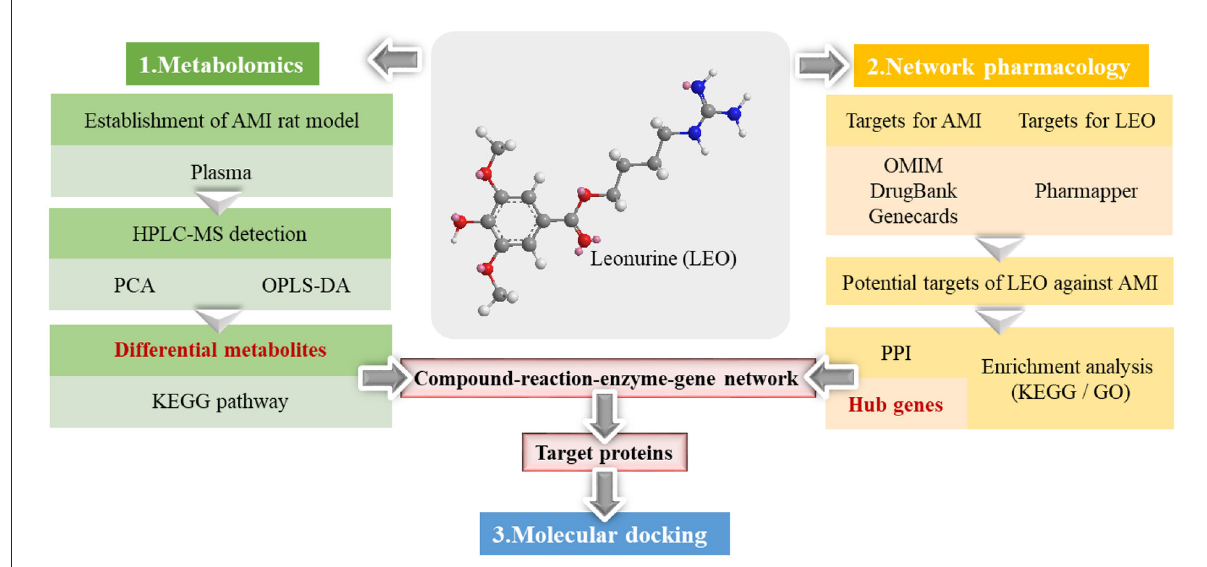
FIGURE1 The workflow of the metabolomics and network pharmacological integration strategy for the study of the leonurine protective mechanism on AMI. The structure of leonurine is shown in the center position. The differential metabolites were first filtered by metabolomics; then, the hub genes were screened by network pharmacology; finally, the key targets were verified by molecular